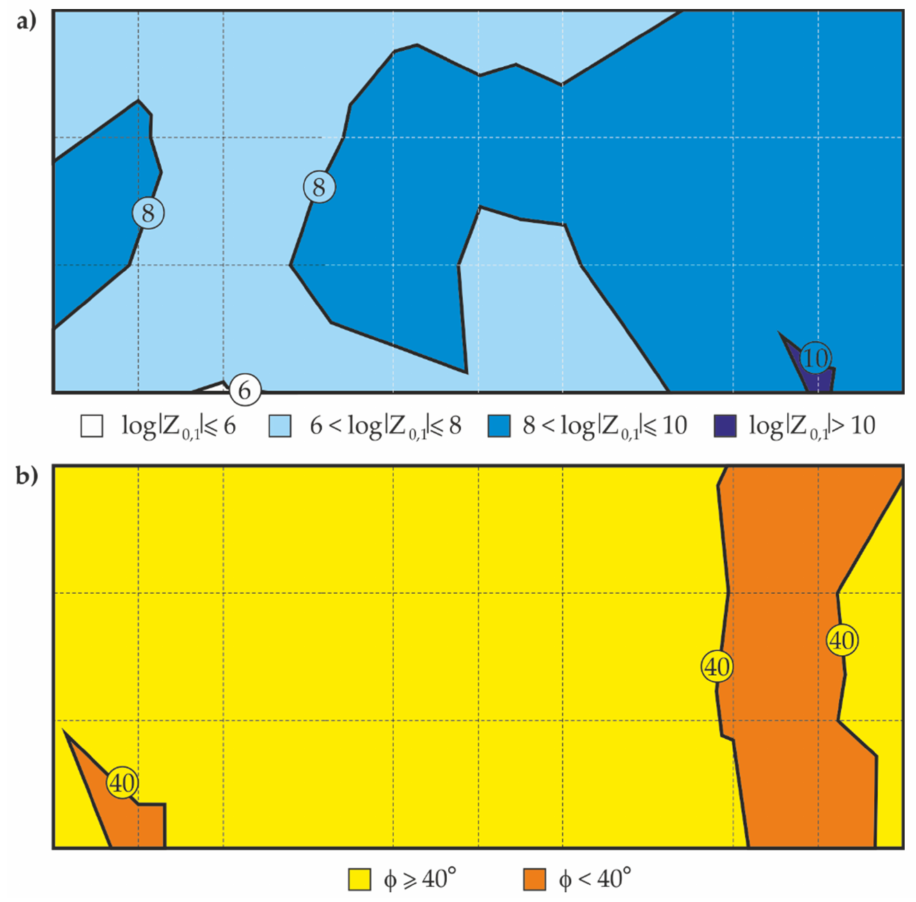
Figure 12. Maps of distribution for the blue coating on the large steel sheet: ( a ) the logarithm of